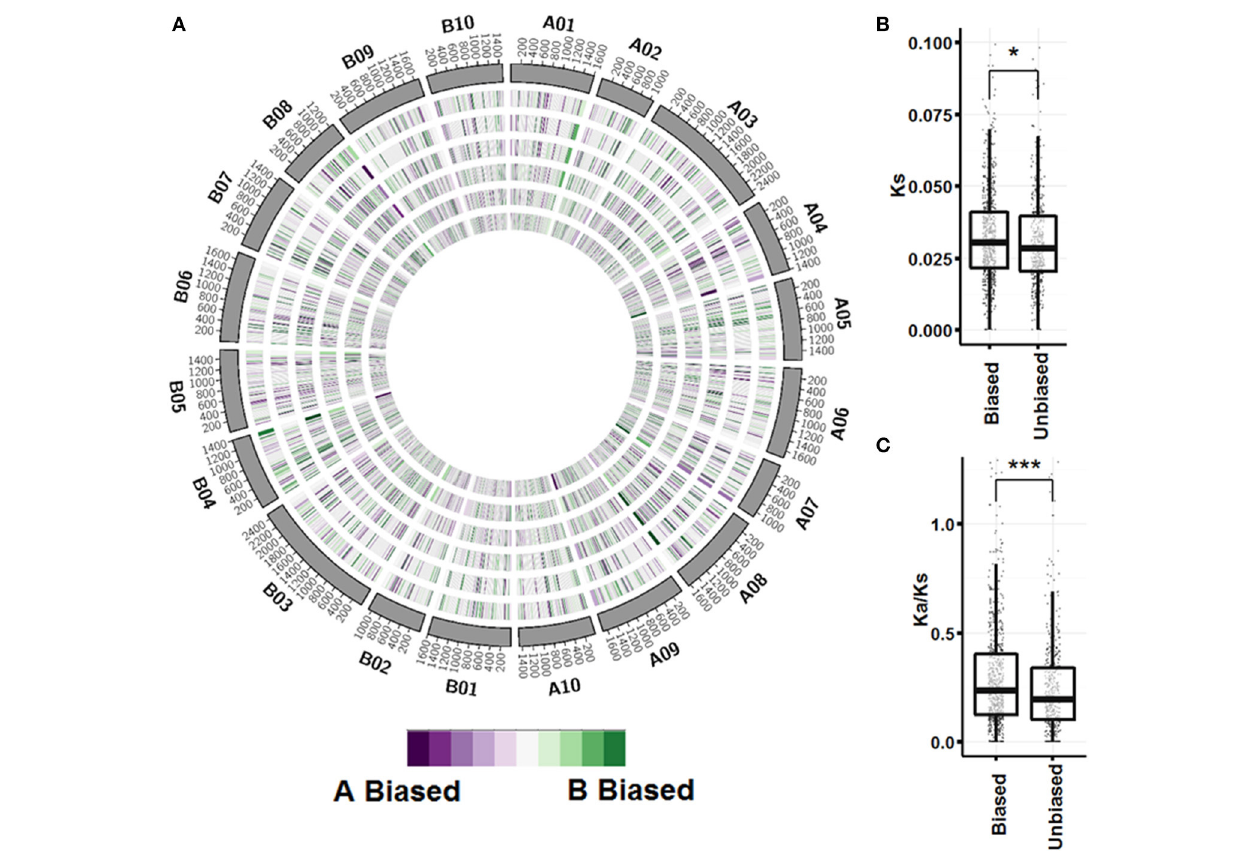
FIGURE 5 | Subgenome expression bias. (A) Circos plot showing expression bias by gene pair position for vegetative tissues. Homeologous pairs were mapped to A. duranensis and A. ipaensis pseudomolecules and assigned a position on the mapped chromosome. Pairs that did not map to their reciprocal chromosomes were not considered. A sliding window of 50 loci in 10 loci increments was used to visualize bias. From outer ring to inner ring; seedling leaf, mainstem leaf, lateral leaf, vegetative shoot tip, roots, nodules. (B) Synonymous substitution rate between unbiased pairs and pairs with significant expression bias in at least 3 tissues (p < 0.05 by Wilcox on rank test). (C) Non-synonymous/Synonymous substitution rate between unbiased and biased pairs ( p < 0.0001 by Wilcox on rank test).